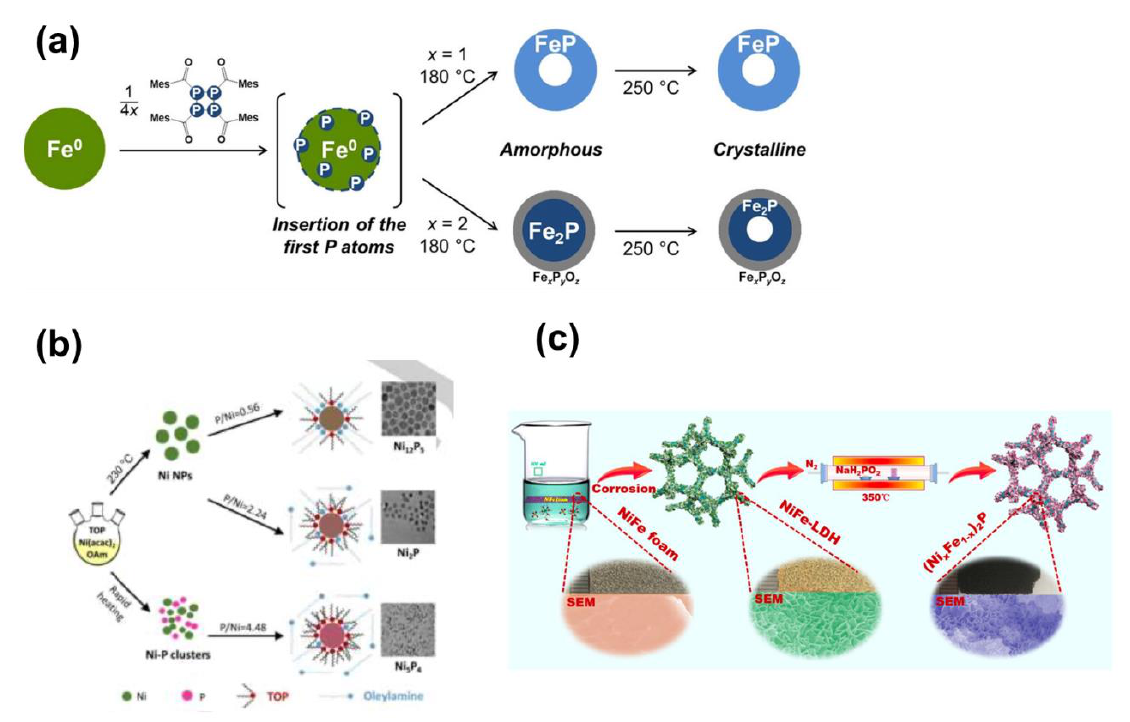
Figure 4. ( a ) Fe-P synthesis. Reprinted with permission from Ref. [97], Copyright 2020 Wily Online; ( b ) NiP nanocrystals formation. Reprinted with permission from Ref. [98], Copyright 2018 Wily Online; ( c ) Synthesis of (Ni x Fe 1 − x ) 2 P nanosheets via phosphorization of the NiFe-LDH precursors. Reprinted with permission from Ref. [99], Copyright 2020 ACS